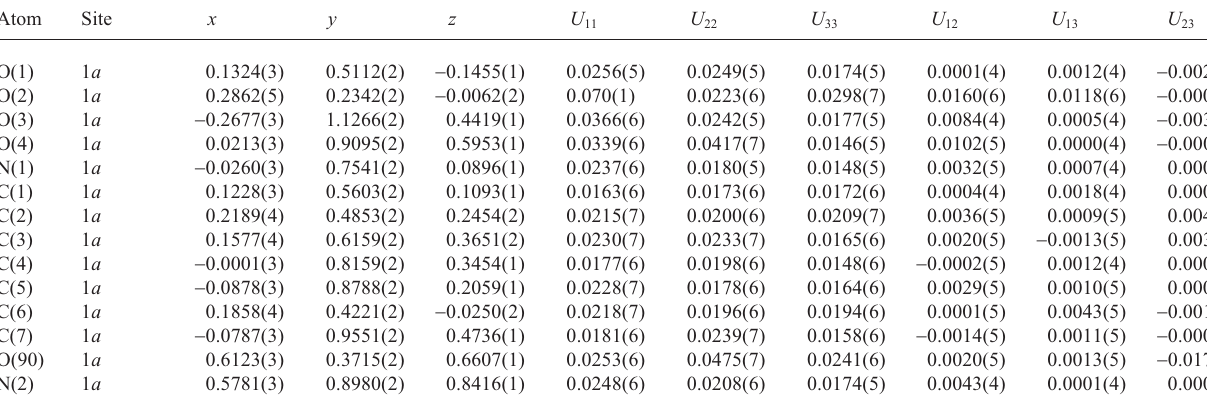
Table 3. Atomic coordinates and displacement parameters (in Å 2 )